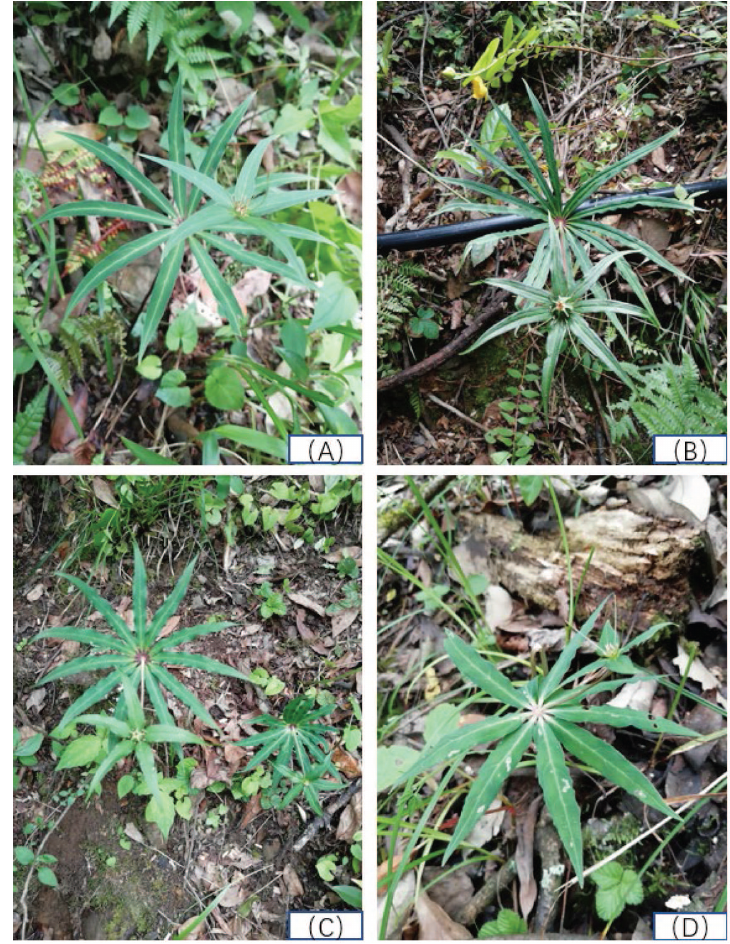
Fig. 1 Paris panxiensis ; wild plants and